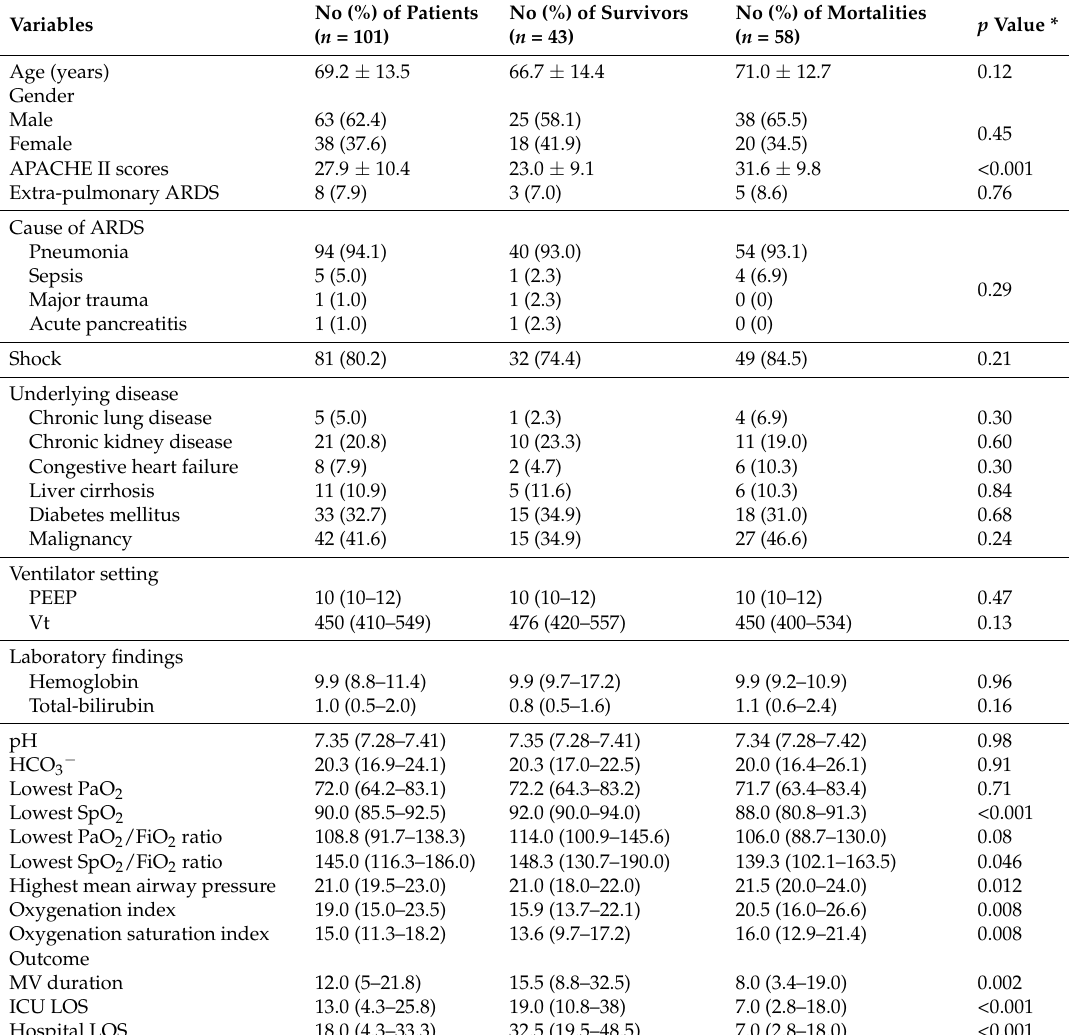
Table 1. Clinical characteristics of patients with